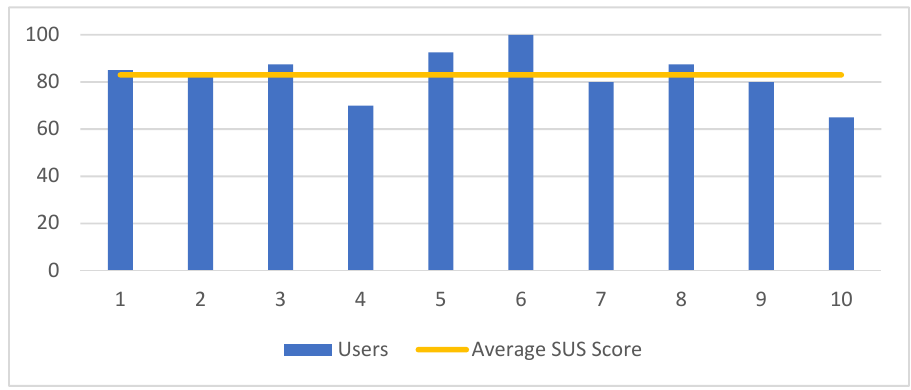
Figure 14. Over SUS score per user.